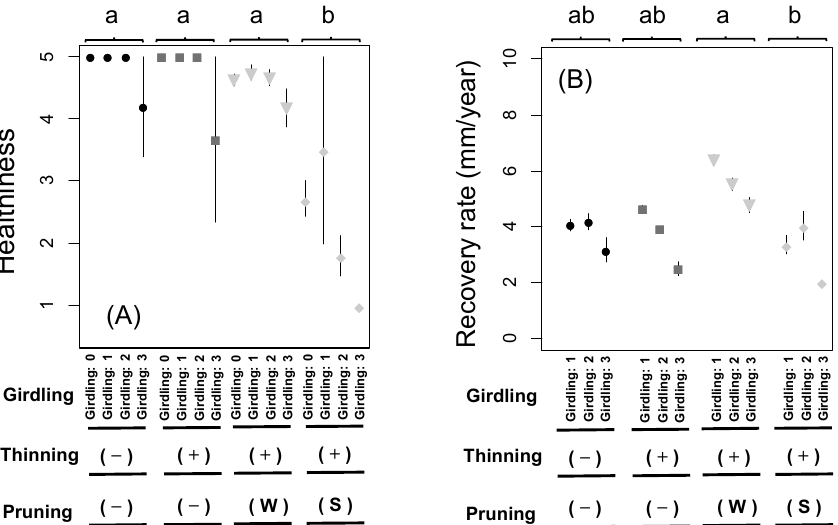
Figure 3. Treatment effects of girdling, thinning and pruning on healthiness index ( A ) and recovery from girdling damage ( B ). Means ( ± SE) are shown in each panel. Different lowercase letters above each panel indicate significant differences between pruning classes based on a post hoc comparison. Table 2. Summary of linear mixed model analysis of healthiness index and recovery rates. The sample sizes ( n ) for girdling levels were 66, 27, 35 and 26 trees to levels 0, 1, 2 and 3,